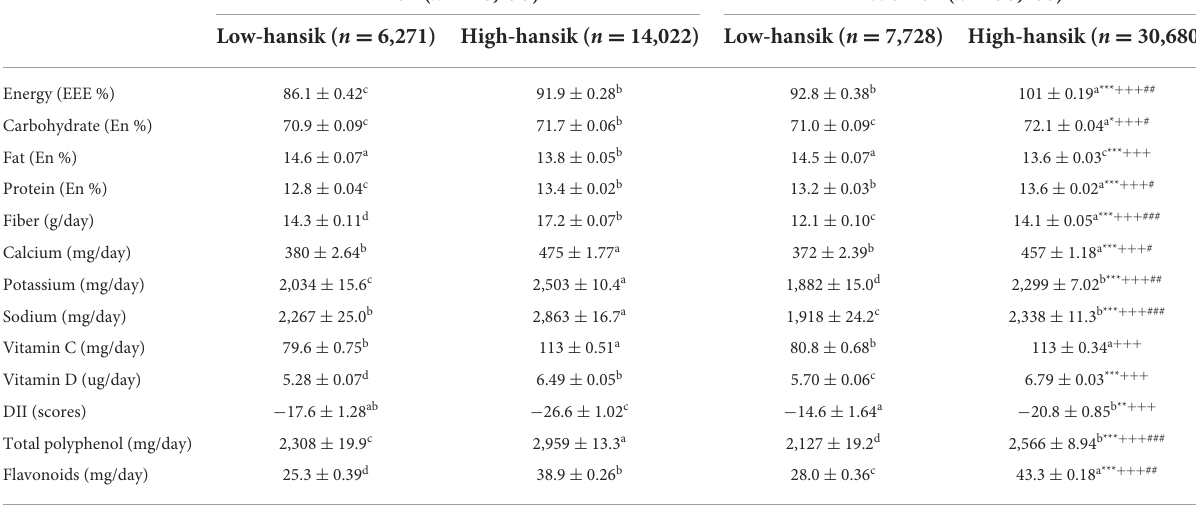
TABLE 4 Nutrient intake according to gender and hansik intake defined by the K diet -index